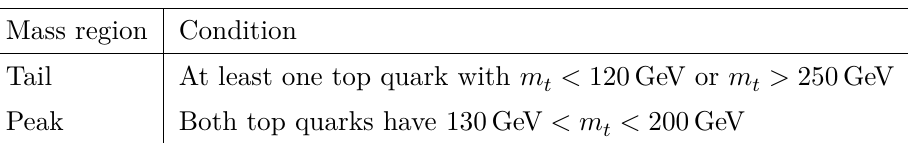
Table 3 . Definition of the mass region based on the m